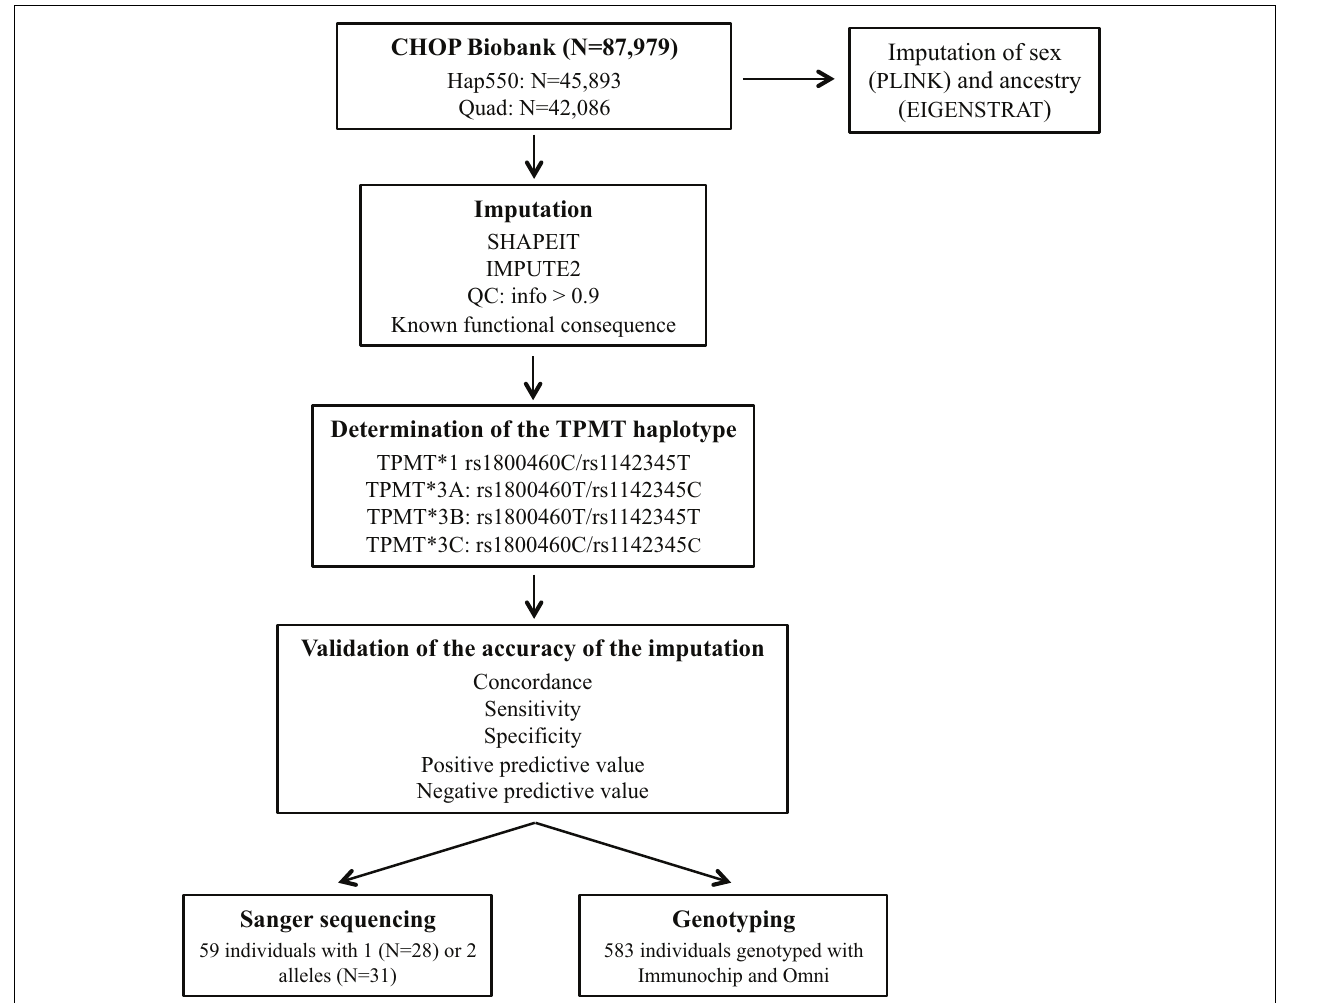
FIGURE 1 | General schema for the study process. Hap550 is the InfiniumII HumanHap550 array, Quad is Human610-Quad version 1 array, Immunochip is the Illumina Infinium Immunochip array and Omni is the HumanOmni1-Quad version 1.